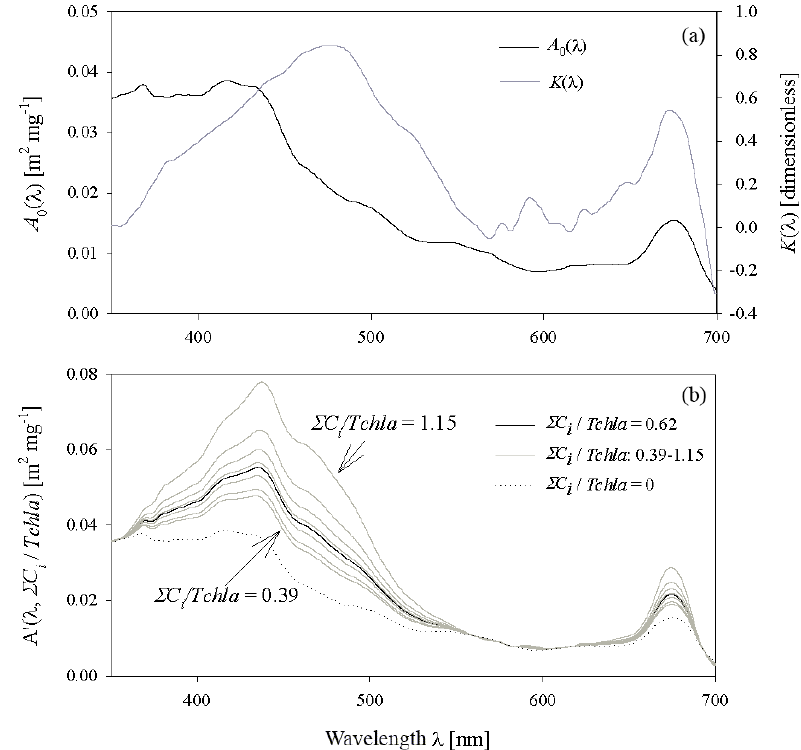
Figure 7. (a) Spectral plots of coefficients A 0 and K of the two-component parameterization described by Eq. (4); (b) examples of curves representing coefficent A (cid:48) (λ , (cid:54)C i / Tchl a ), defined by Eq. (5), for the following values of (cid:54)C i / Tchl a : the average value of 0.62; selected values between 0.39 and 1.15 (representing the range from the 10th percentile for the December–January period to the 90th percentile for May); the hypothetical value of